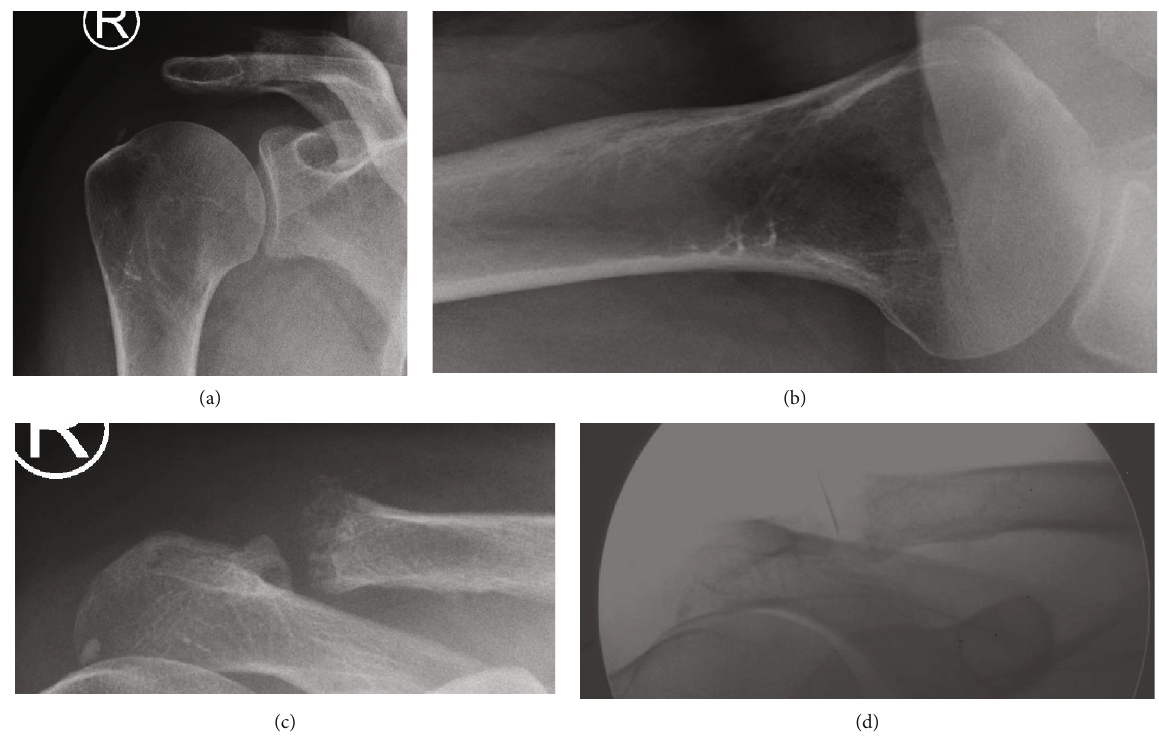
Figure 1: X-ray and fl uoroscopic views of the right shoulder. (a) Anterior-posterior view. (b) Axial view. (c) Zanca view. (d) Acromioclavicular small-needle aspiration under fl uoroscopic guidance.